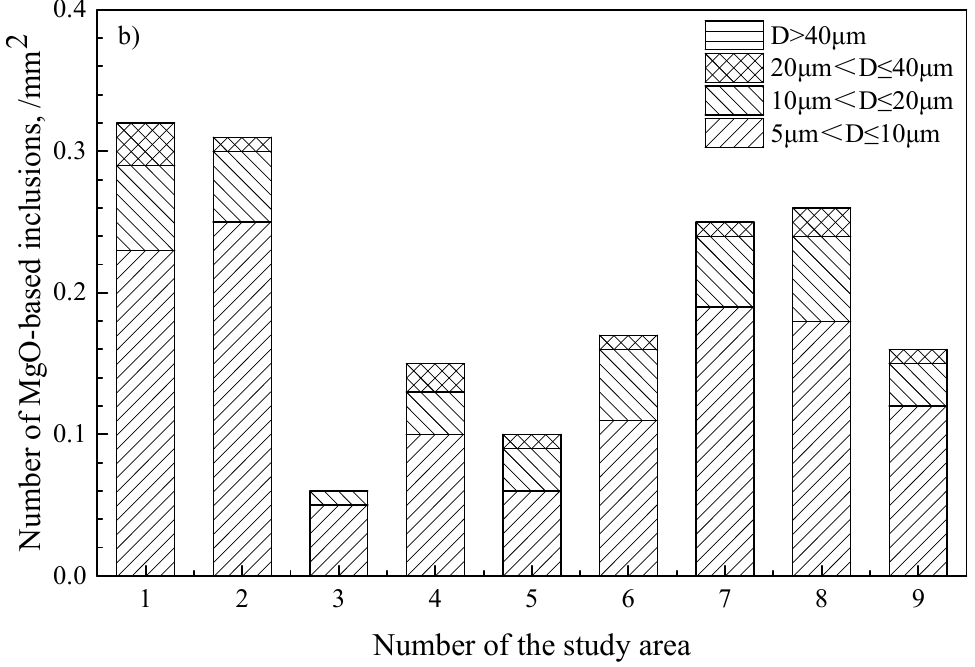
Figure 7. Size distribution of inclusions in the billet. ( a ) all types of inclusions; ( b ) MgO-based inclusions.